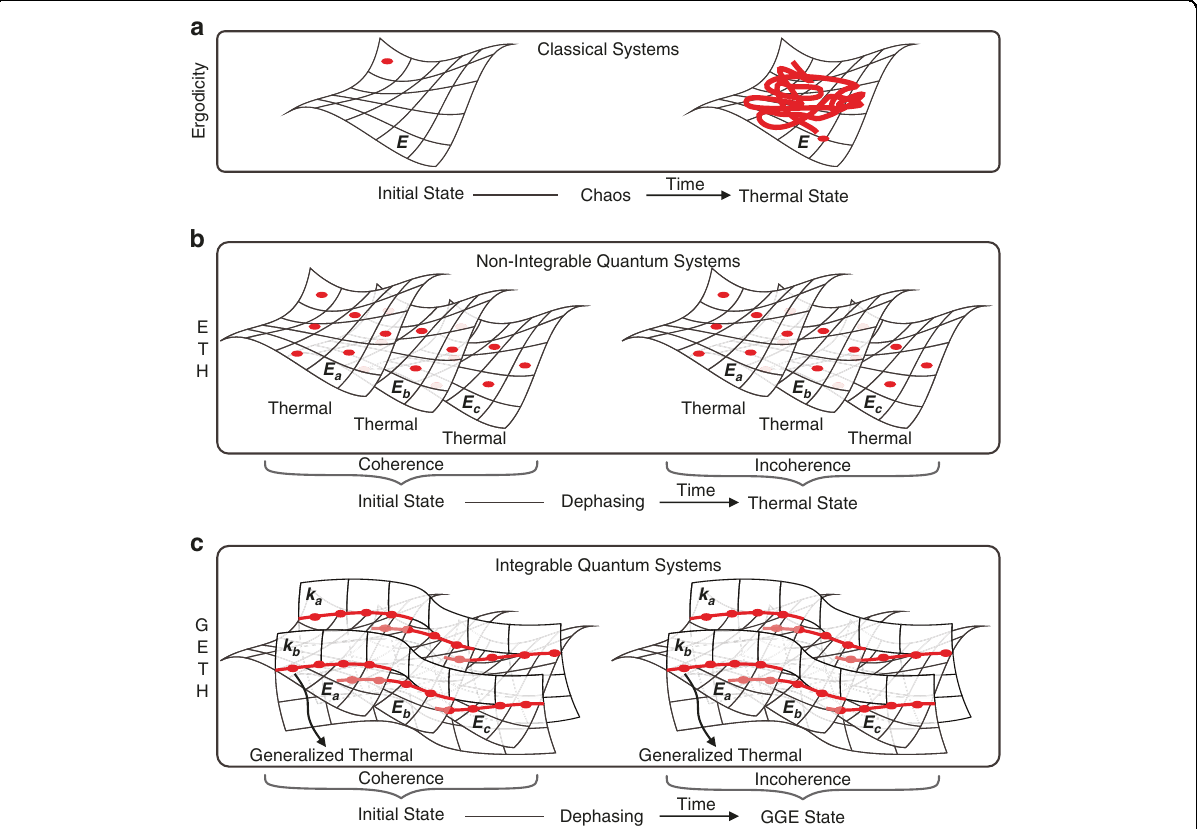
Fig. 1 Mechanism of the thermalization and the generalized thermalization. An illustration of the following three points: a the ergodicity in classical systems, b the ETH supporting the thermalization in non-integrable quantum systems 6 , and c the GETH supporting the generalized thermalization in integrable quantum